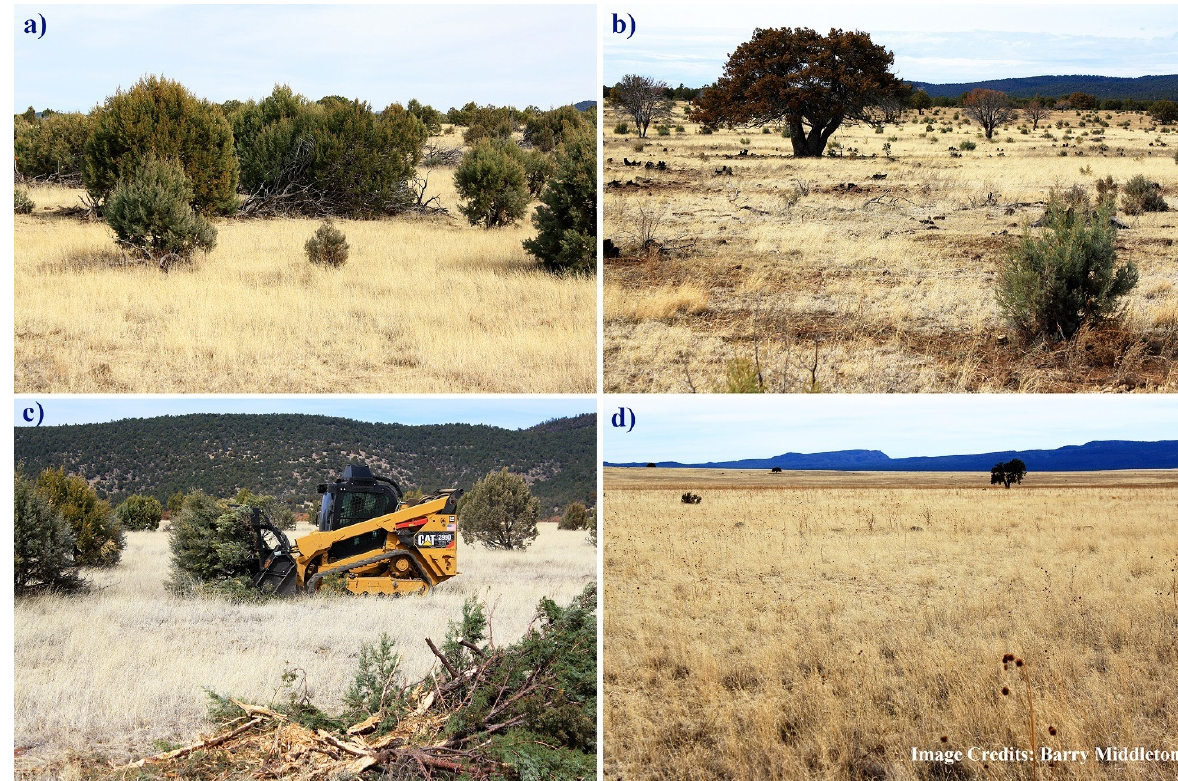
Figure 3. Managed landscapes on Bee Flat and Big Prairie Grasslands. ( a ) Image of area (Bee Flat) once treated to remove junipers by chaining. The chaining was carried out many years before the image is taken; ( b ) image of area (Bee Flat) treated to restore savanna environment by cutting down junipers; ( c ) shredding machine used by San Carlos Apache Tribe, with image taken in Bee Flat study area; ( d ) Big Prairie grasslands, with image taken in Big Prairie study area.